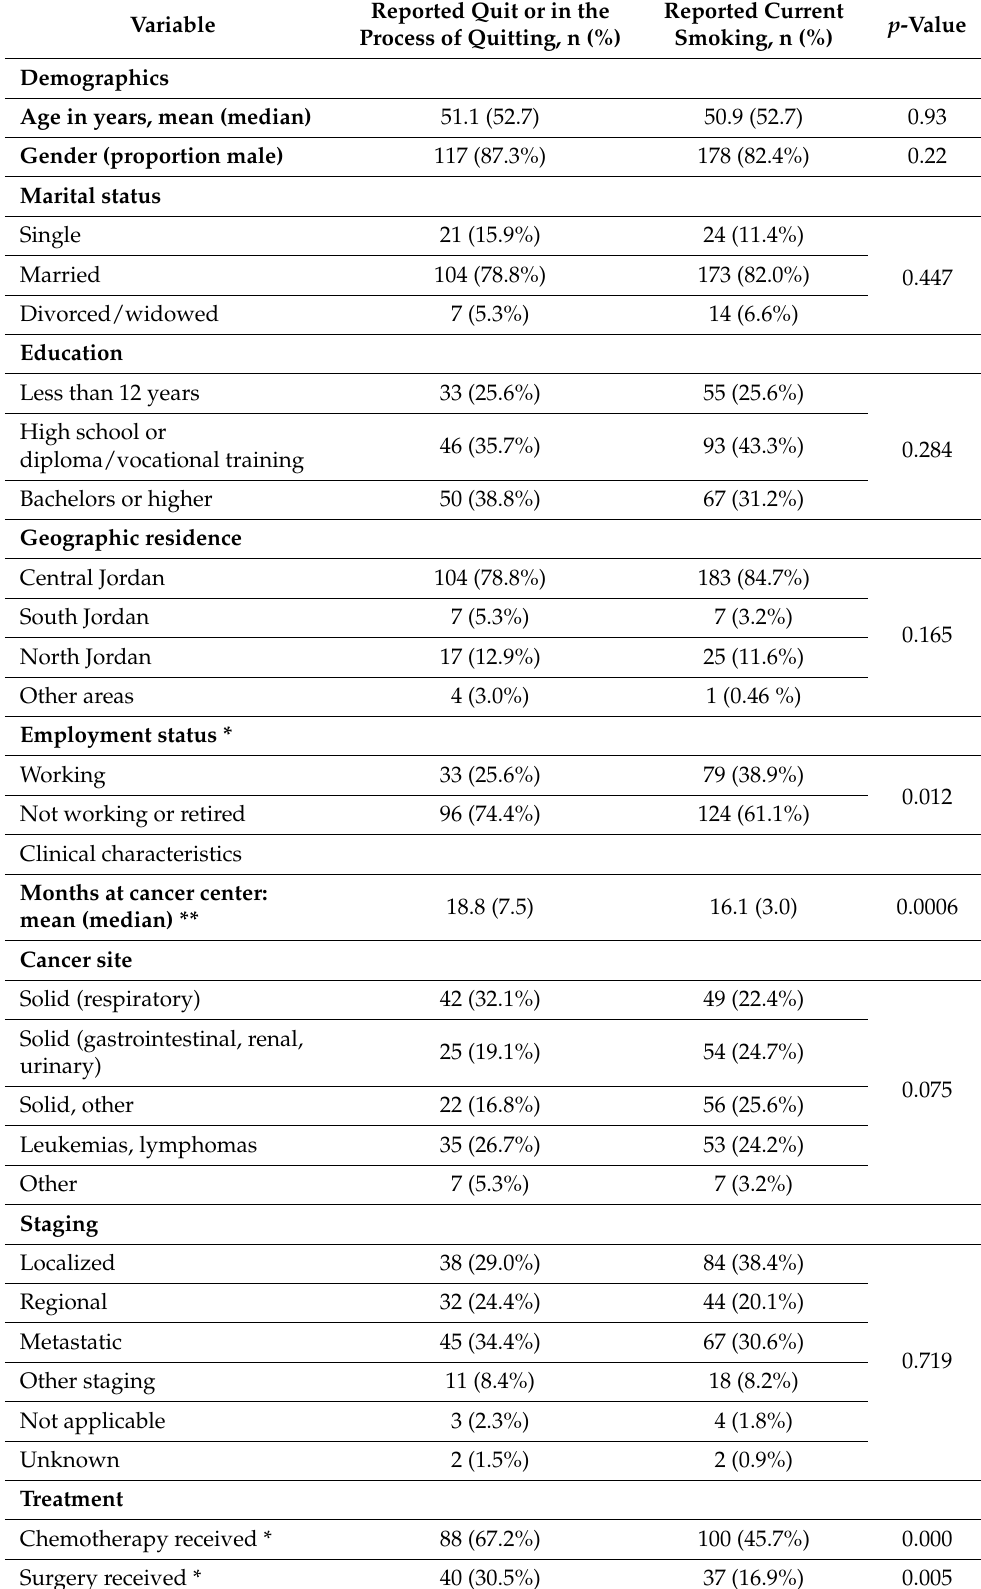
Table 1. Demographic, clinical, and tobacco use characteristics of a sample of cancer patients who currently smoke versus those who smoked up to diagnosis and then quit (column totals